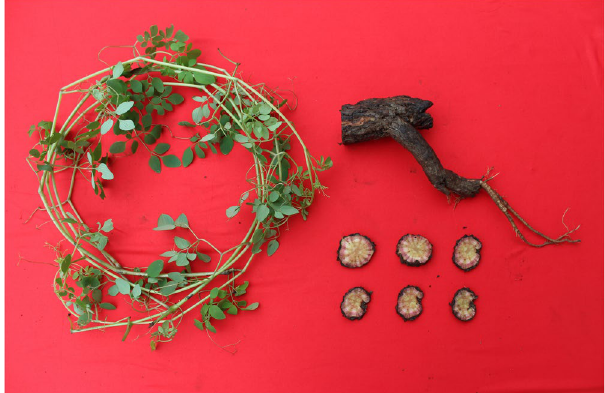
Figure 1. Roots, leaves and stems of D . scandens . Wild seedlings of D . scandens were transplanted into the field for 1.5